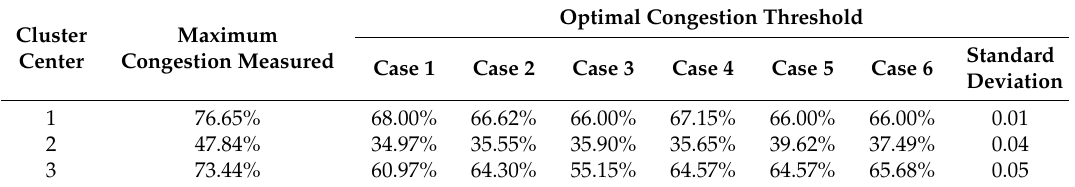
Table 6. Optimal congestion thresholds of the cluster